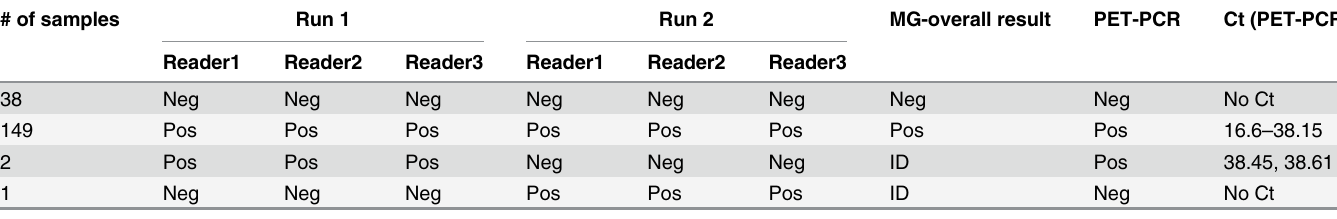
Table 2. Comparison of MG-LAMP to